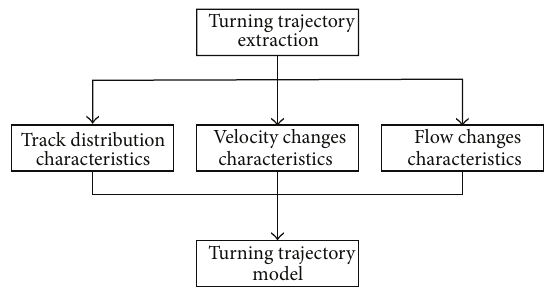
Figure 1: The establishment process of the trajectory